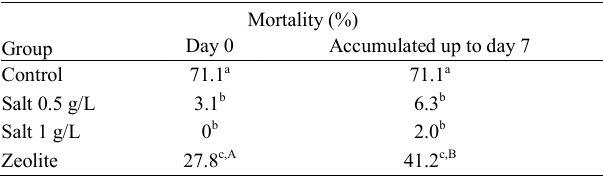
Table 3. Mortality at the end of shipment of Ancistrus triradiatus in plastic bags and 7 days after transport. Different lowercase letters indicate significant difference between groups in the same day. Different capital letters indicate significant difference between days 0 and 7 for the same